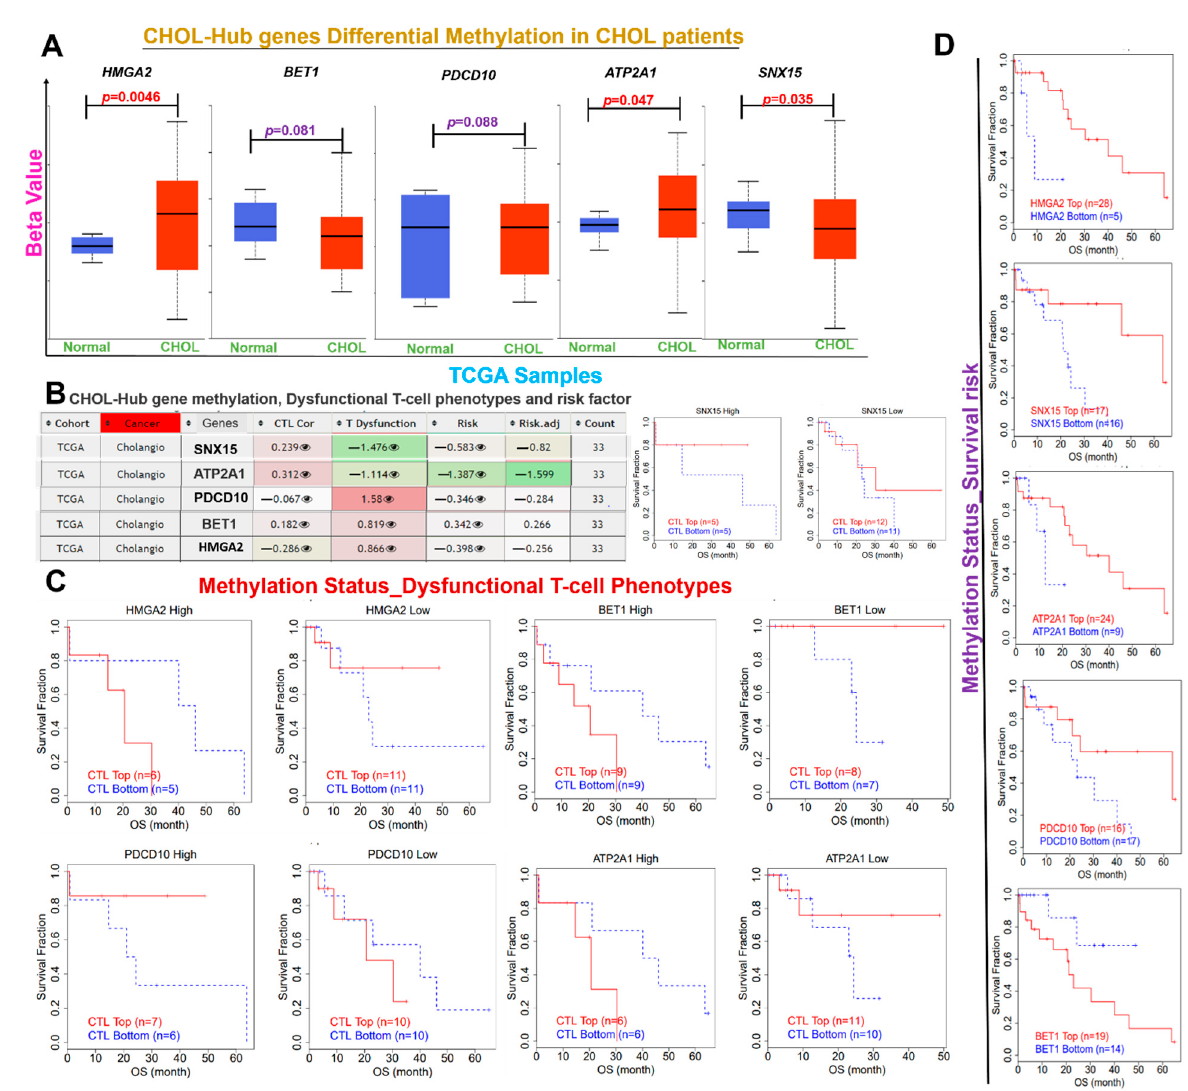
Figure 5. Differential Methylation of CHOL-Hub gene is associated with Dysfunctional T-cell Phenotypes in CHOL patients. ( A ) Boxplot showing differential methylation levels of CHOL-hub genes between TCGA CHOL tumor samples and healthy. ( B ) Heatmap of CHOL-Hub gene methylation and its association with Dysfunctional T-cell phenotypes and risk factor of CHOL patients. ( C ) Kaplan–Meier plot showing the association between the methylation status of the CHOL-hub gene and dysfunctional T-cell phenotypes of CHOL patient ( D ) Kaplan–Meier plot showing the association between the methylation status of the CHOL-hub gene and survival risk of CHOL patient.